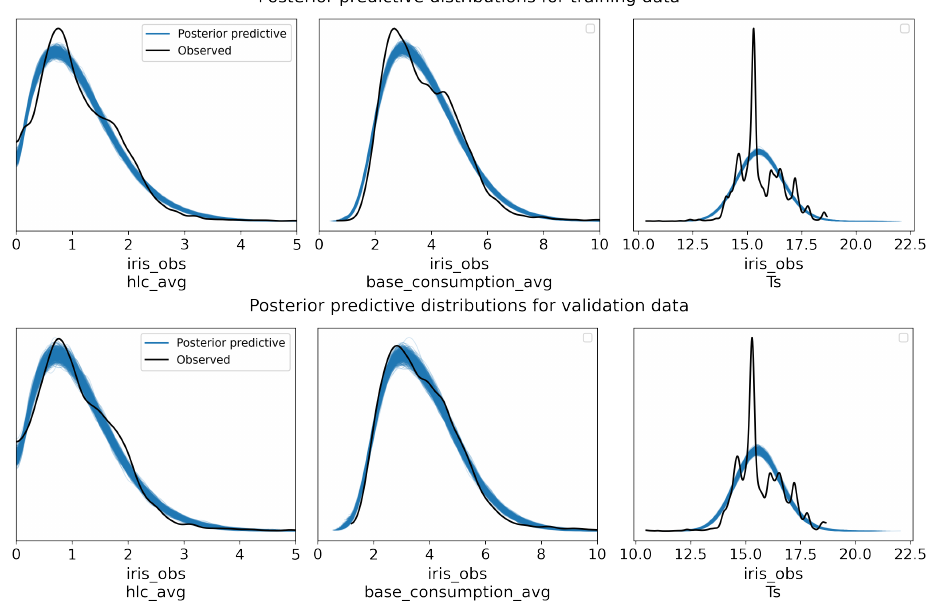
Figure 11. Posterior predictive distributions for training and validation data—surfaces model.